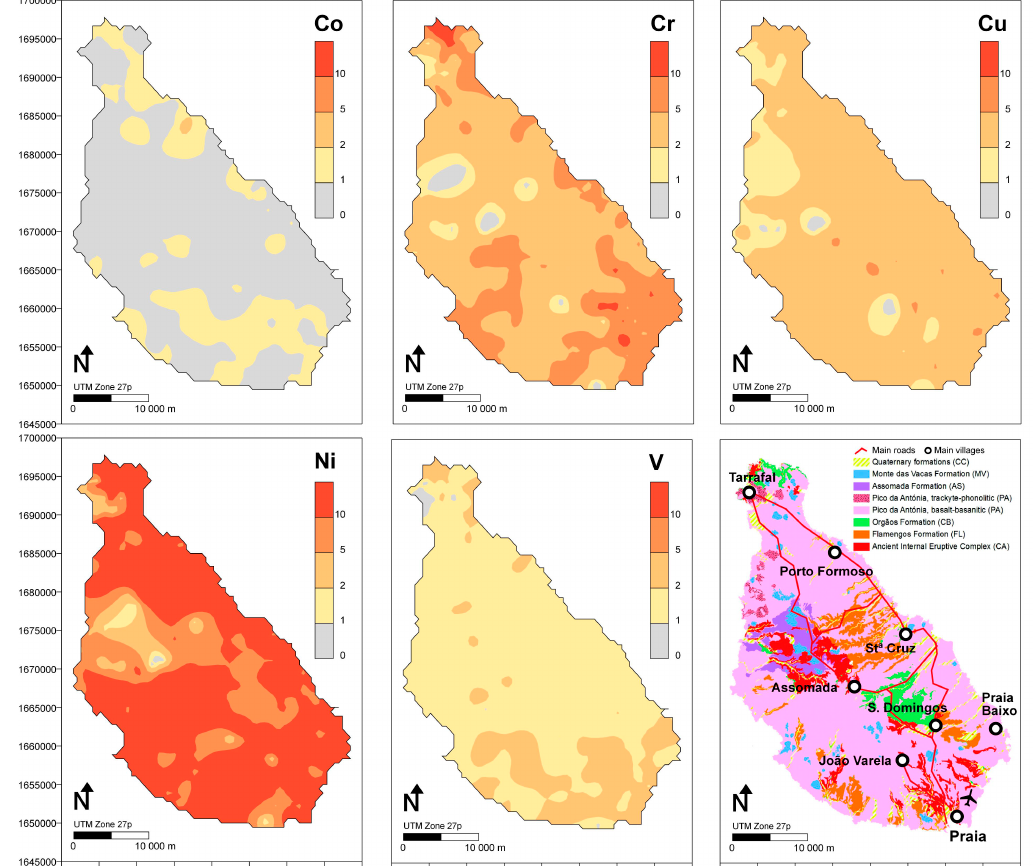
Figure 4. Environmental Risk Index (ERI) of some metals for all types of property uses. The geological map of Figure 1 is shown in the last panel for easier comparison with the ERI spatial